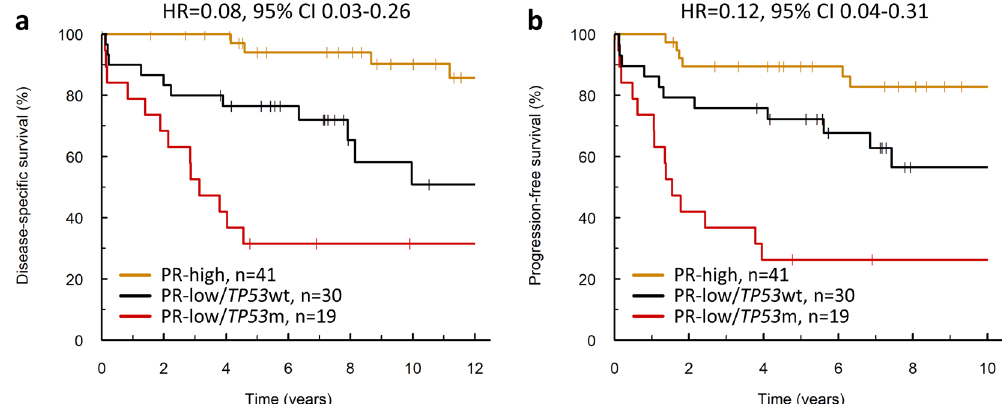
Fig. 5 Clinical outcome of endometrioid ovarian carcinoma cases de fi ned by combined HREP-based subtyping and TP53 mutation status. a Disease-speci fi c survival. Labelled hazard ratio (HR) represents comparison of PR-high with PR-low/ TP53 m group ( P < 0.0001); additionally, HR for PR-high vs PR-low/ TP53 wt = 0.21, 95% CI 0.07 – 0.67 and HR for PR-low/ TP53 m vs PR-low/ TP53 wt = 2.56, 95% CI 1.14 – 5.75. b Progression-free survival. Labelled HR represents comparison of PR-high with PR-low/ TP53 m group ( P < 0.0001); additionally, HR for PR-high vs PR-low/ TP53 wt = 0.34, 95% CI 0.13 – 0.92 and HR for PR-low/ TP53 m vs PR-low/ TP53 wt = 2.93, 95% CI 1.32 – 6.51. PR, progesterone receptor; m, mutant; wt, wild-